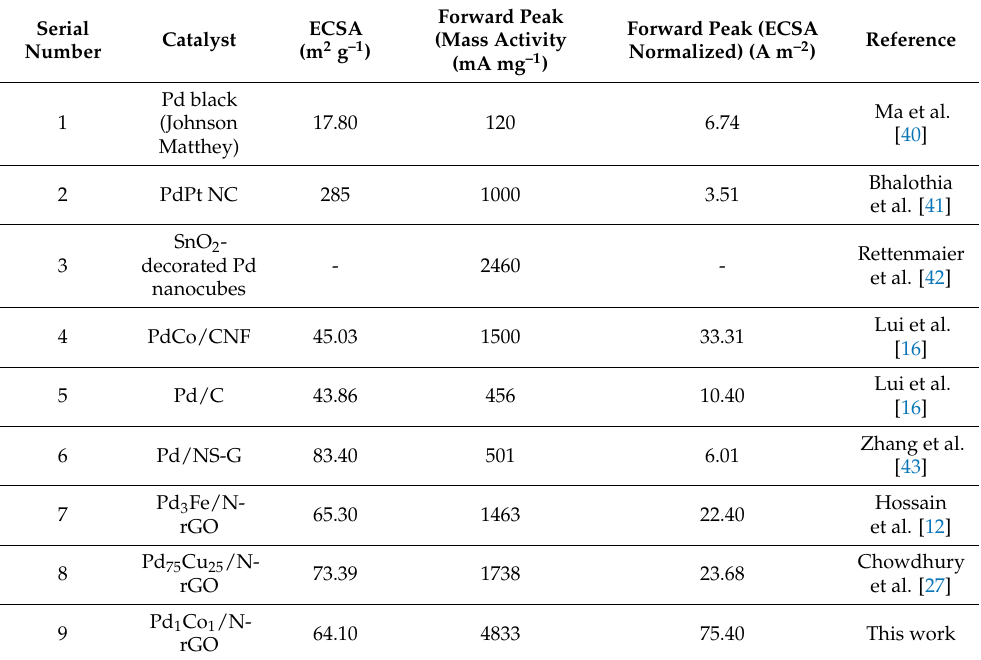
Table 3. Comparison of the ECSA and mass activity for the as-prepared catalysts with the reported literature values under identical test